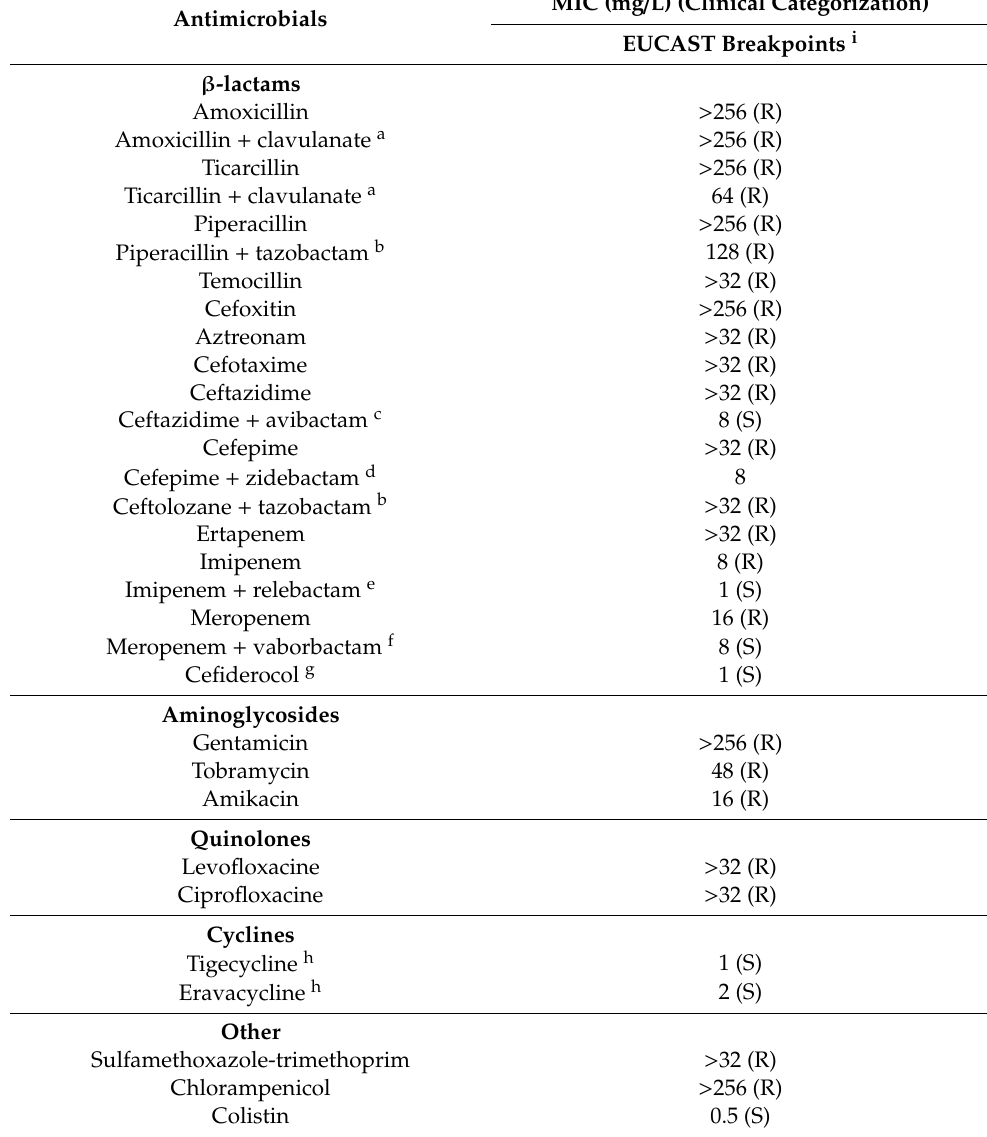
Table 1. Antimicrobial minimal inhibitory concentrations of the E. hormaechei subsp. ho ff manni. MIC (mg / L) (Clinical Categorization) Antimicrobials EUCAST Breakpoints i β -lactams Amoxicillin > 256 (R) Amoxicillin + clavulanate a > 256 (R) Ticarcillin > 256 (R) Ticarcillin + clavulanate a 64 (R) Piperacillin > 256 (R) Piperacillin + tazobactam b 128 (R) Temocillin > 32 (R) > 256